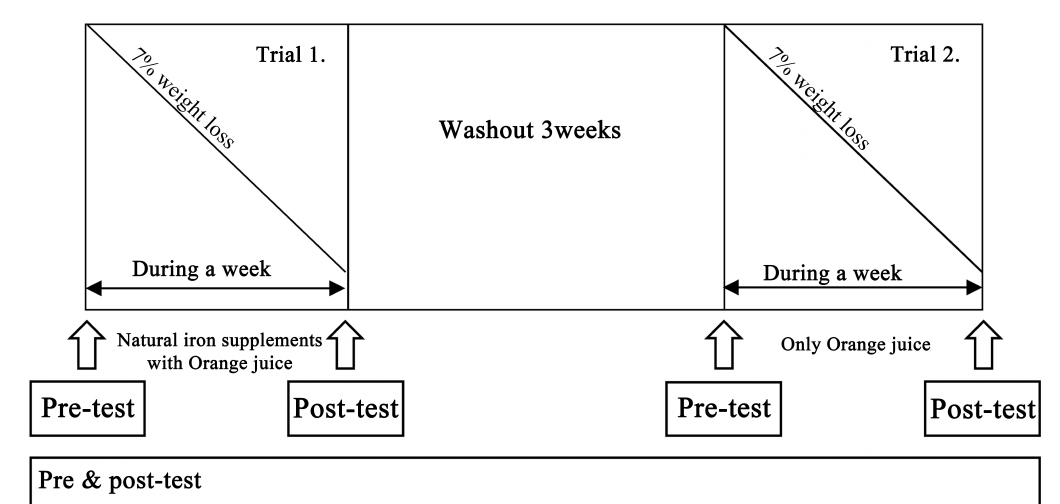
Fig. 1. The experimental